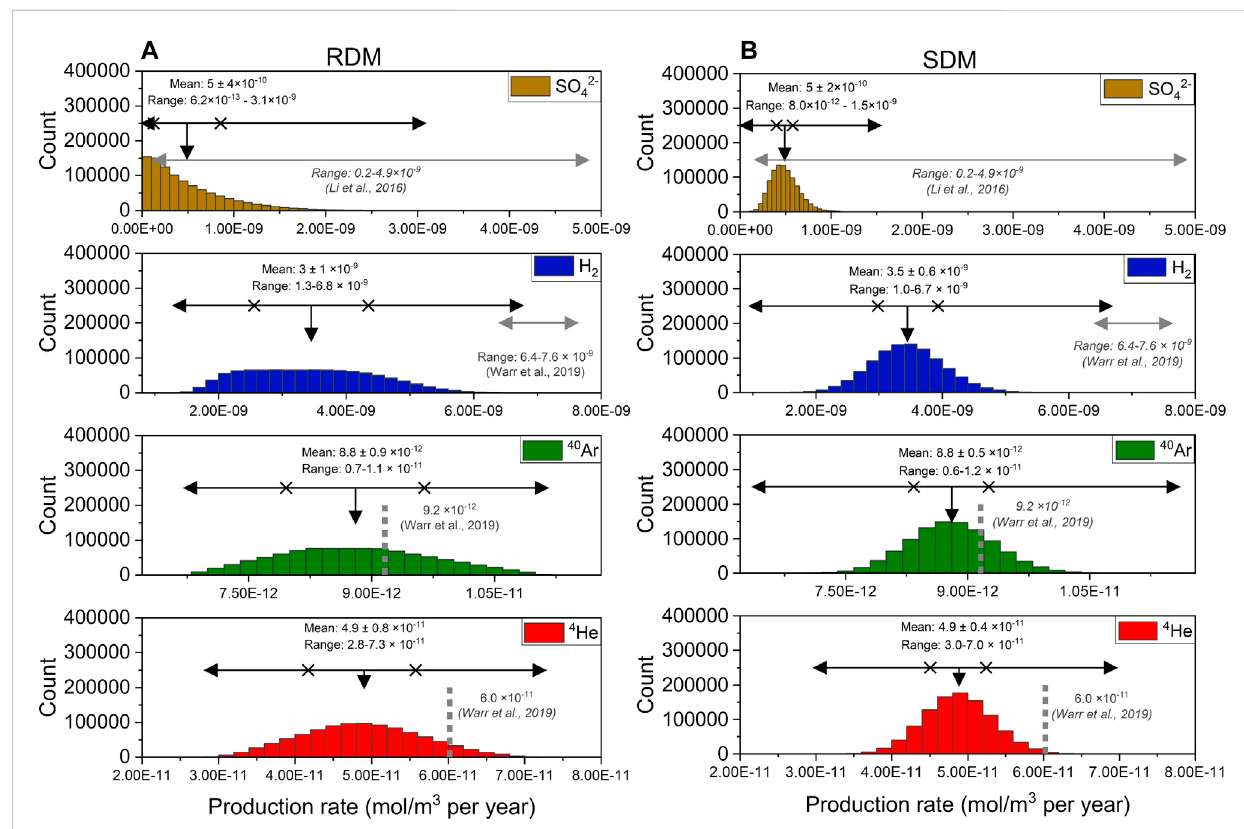
FIGURE 1 Production rates for 4 He, 40 Ar, H 2 , and SO 4 2- in moles per bulk m 3 rock per year determined using Eqs 1 – 9, via the random distribution Monte Carlo approach (RDM) (A) and the standard distribution Monte Carlo approach (SDM) (B) . The results incorporate the input parameters provided in Table 1 and aredescribedinfullinthemaintext.PreviouslycalculatedproductionratesbyLietal.(2016)forSO 4 2- ;Warretal.(2019)forH 2 , 4 He,and 40 Arareplottedas lightgreyhorizontallinesforH 2 andSO 4 2- andingreyverticalhatchedlinesfor 4 Heand 40 Ar.SO 4 2- productionfromLietal.(2016)isconvertedfrom thereportedproduction(moles perliterperyear)toproductioninmoles perm 3 bulk rockperyearusingEq. 9and aporosityof1%asinthe Lietal. (2016) published model. On all fi gures the black horizontal arrows represent the range (maximum-minimum) for the results from this study, the vertical black arrows represent the average (mean), and the crosses represent the associated standard deviation (1 σ